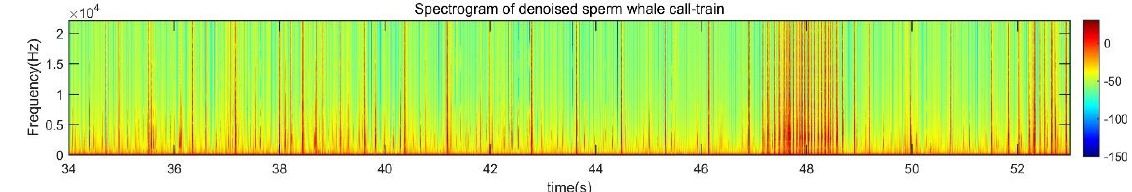
Figure 4. The spectrogram of the denoised sperm whale call-train.